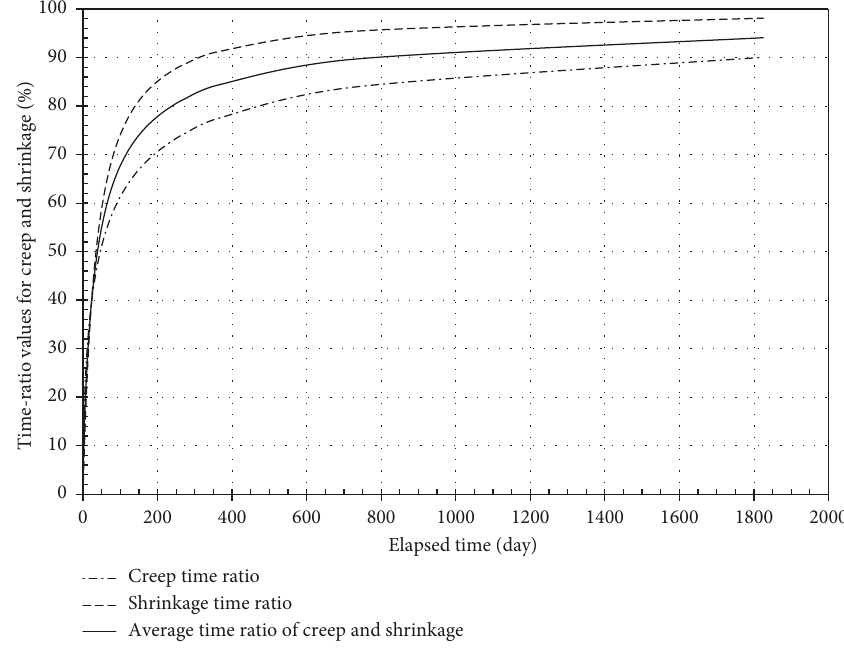
Figure 1: Rate of creep and drying shrinkage over